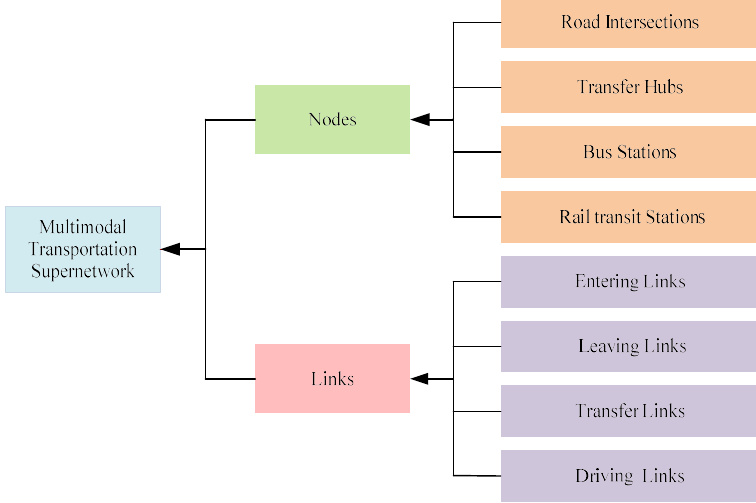
Figure 1. The structure diagram of elements in the multimodal transportation super network.